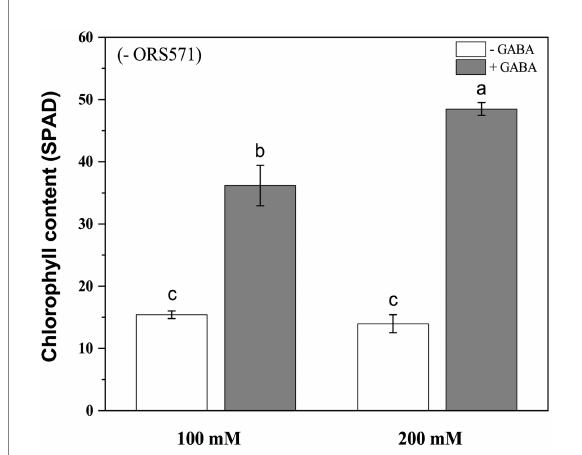
FIGURE 5 Chlorophyll content of Sesbania rostrata under NaCl stress with or without GABA. The chlorophyll content of GABA treatment was significantly higher than that of the control under salt stress. Different lower-case letters in each column shape indicate a significant difference at p < 0.05 by statistical analysis. Error bars indicate standard deviations from four parallel replicates.